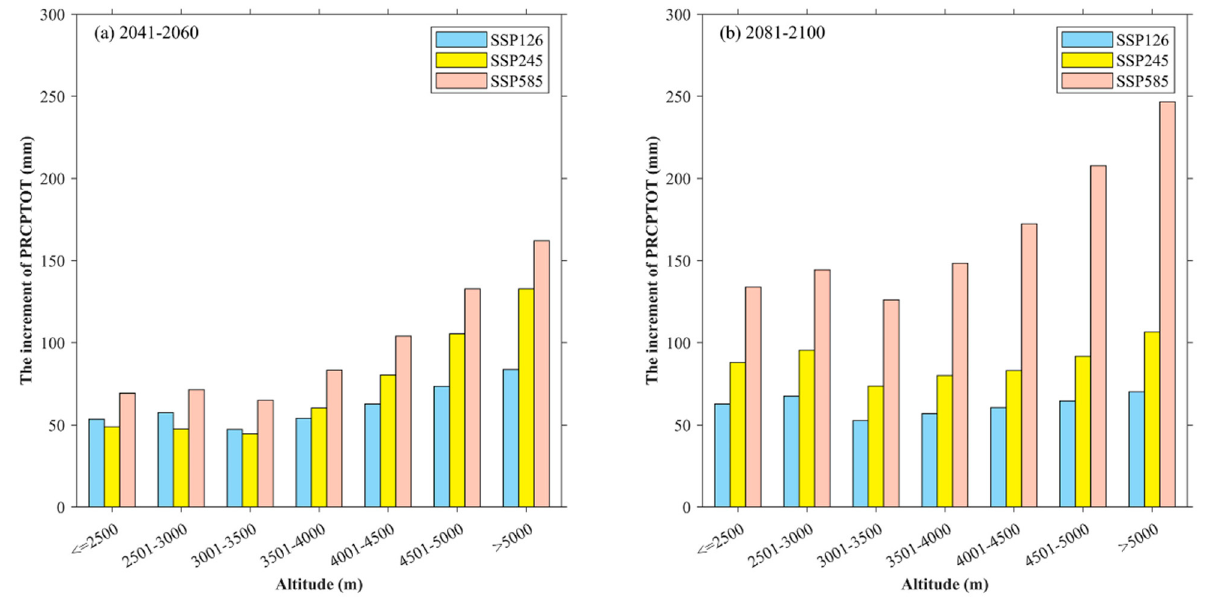
Figure 15. PRCPTOT increments at different altitudes of the Qilian Mountains in the middle and late 21st century compared with the historical period.